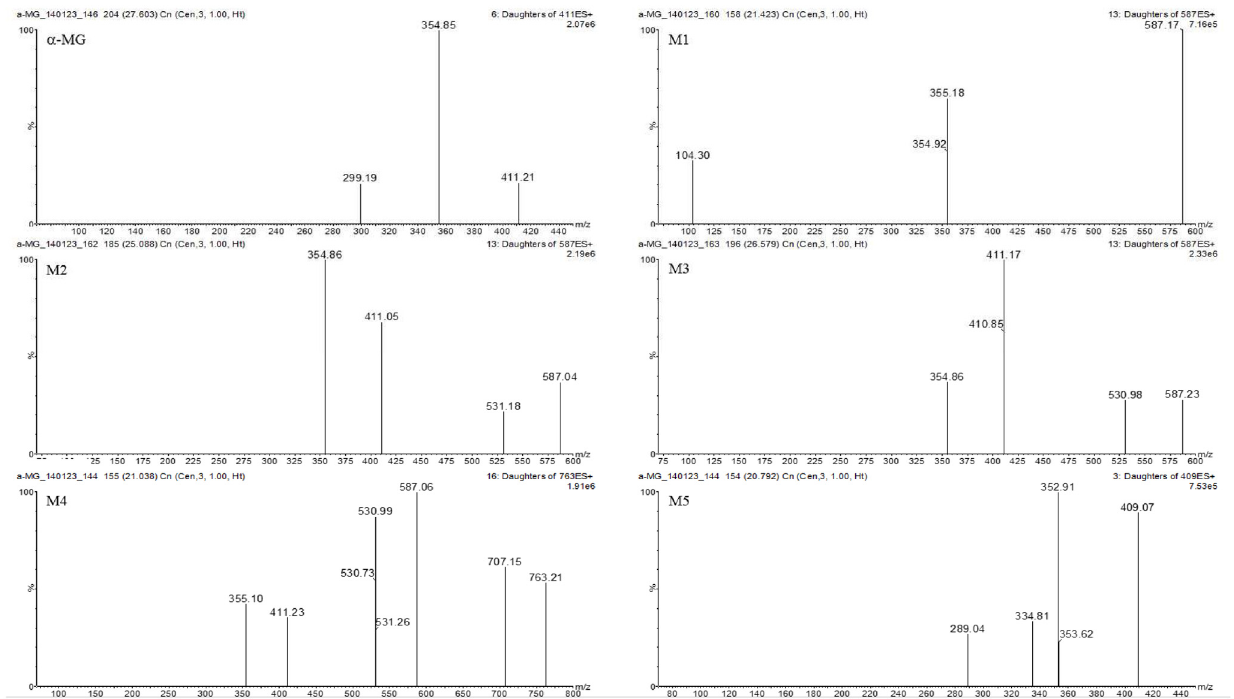
Fig 4. Spectrums of α -MG and its tentative metabolites (M1 – M5) detected in mice ’ s plasma, urine, feces, liver and small intestine after intravenous and oral administration of α -MG and S9 fractions of the liver and small intestine after 30 min incubation.